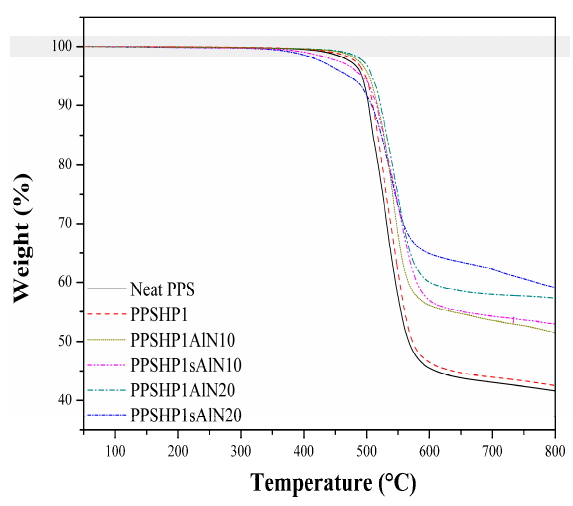
Figure 7. Thermal conductivity of the PPS/MWCNTs/AlN composites.